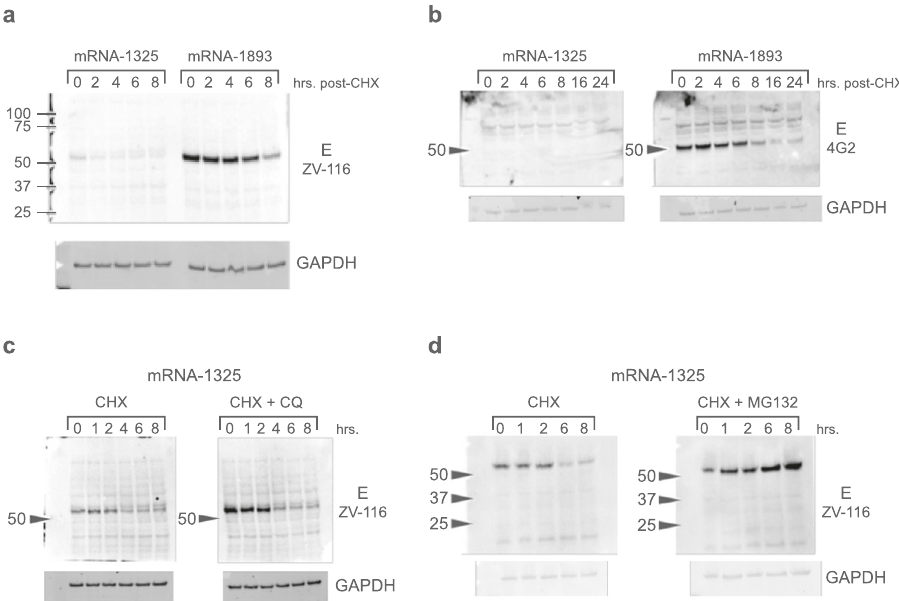
Fig. 2 Time course of intracellular E protein generated by mRNA-1325. a E protein expression was assessed in cell lysates from mRNA- transfected cells, following the addition of CHX and using antibody ZV-116. b E protein levels were also assayed, following the addition of CHX and using the anti- fl avivirus fusion loop antibody 4G2, under non-reducing conditions. c 293T cells were transfected with mRNA-1325 and were treated with CHX or CHX + CQ, harvested at the indicated time points following treatment, and blotted for E using ZV-116. d 293T cells were transfected with mRNA-1325 and were treated with CHX or CHX + MG132 to block proteasomal degradation. a – d Molecular weights were estimated using Precision Plus Dual Color Standards (Bio-Rad). CHX, cycloheximide; CQ, chloroquine; E,